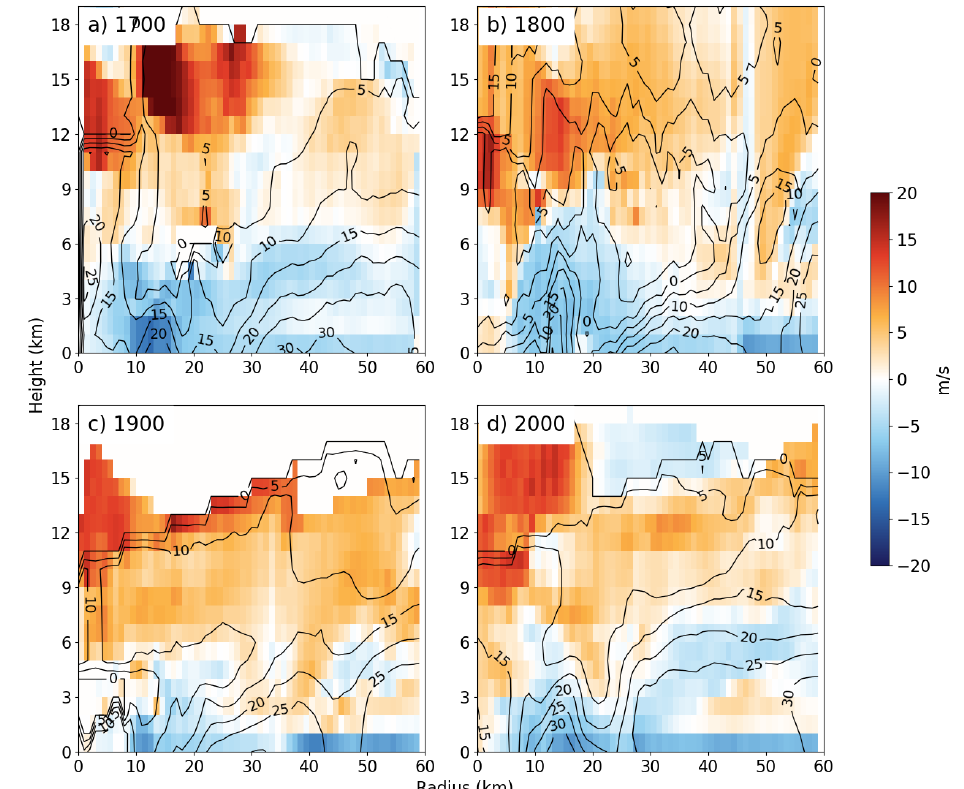
Figure 10. Variations of the radial wind (color shading) and reflectivity (black contour) azimuth means in the upwind of stratiform rainband at 270–340° with horizontal radius of 0–60 km outward from typhoon center with altitude at ( a ) 17:00, ( b ) 18:00, ( c ) 19:00 and ( d ) 20:00 UTC. The cool color of radial wind azimuth mean represents the inflow and the warm color the outflow.